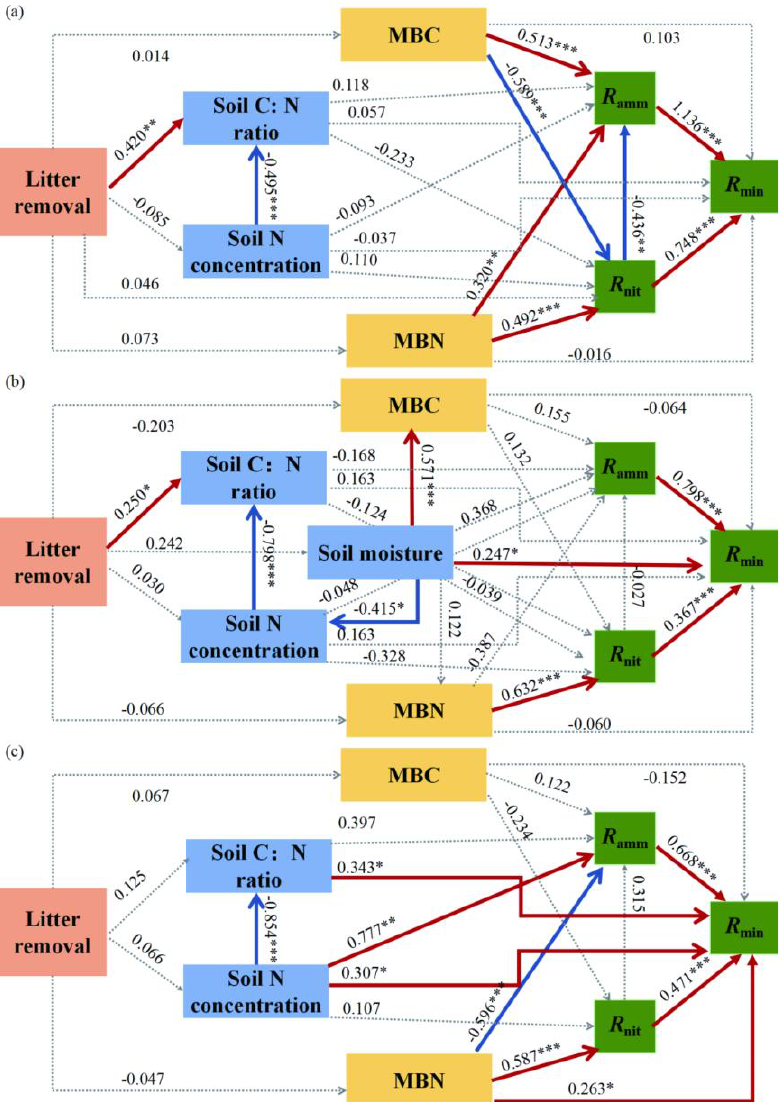
Figure 4. Structural equation models (SEMs) showing the effects of the litter treatment, soil moisture, MBC, MBN, N concentration, and C:N ratio on the net soil ammonification ( R amm ), nitrification ( R nit ), and N mineralization ( R min ) rates in coniferous ( a ), mixed ( b ), and broad-leaved ( c ) forests. Red (positive) and blue (negative) indicate significant and gray indicate insignificant ( p > 0.05) effects, respectively. ( a ) Coniferous forest model satisfactorily fit the data based on the χ 2 = 6.911, df = 7, χ 2 / df = 0.987, NFI = 0.955, CFI = 1.000, and RMSEA = 0.000. ( b ) Mixed forest model satisfactorily fit the data based on the χ 2 = 10.767, df = 9, χ 2 / df = 1.196, NFI = 0.928, CFI = 0.983, and RMSEA = 0.078. ( c ) Broad-leaved forest model satisfactorily fit the data based on the χ 2 = 10.118, df = 9, χ 2 / df = 1.124, NFI = 0.931, CFI = 0.990, and RMSEA =0.062. * p < 0.05, ** p < 0.01, *** p < 0.001. Table 2. Standardized total, direct, and indirect effects were estimated by the structural equation models (SEMs) to assess the effects of litter treatment, soil moisture, MBC, MBN, N concentration, and C:N ratio on the net soil ammonification ( R amm ), nitrification ( R nit ), and N mineralization ( R min ) rates in subalpine forests.